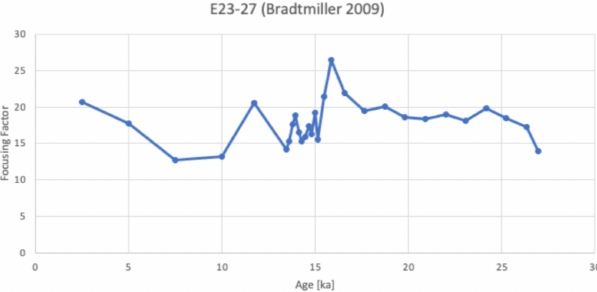
Figure C1. Preliminary focusing factor (FF) values for E27-23. These results suggest notable lateral sediment redistribution over the last 26ka, requiring further analysis (Bradtmiller et al., 2009).